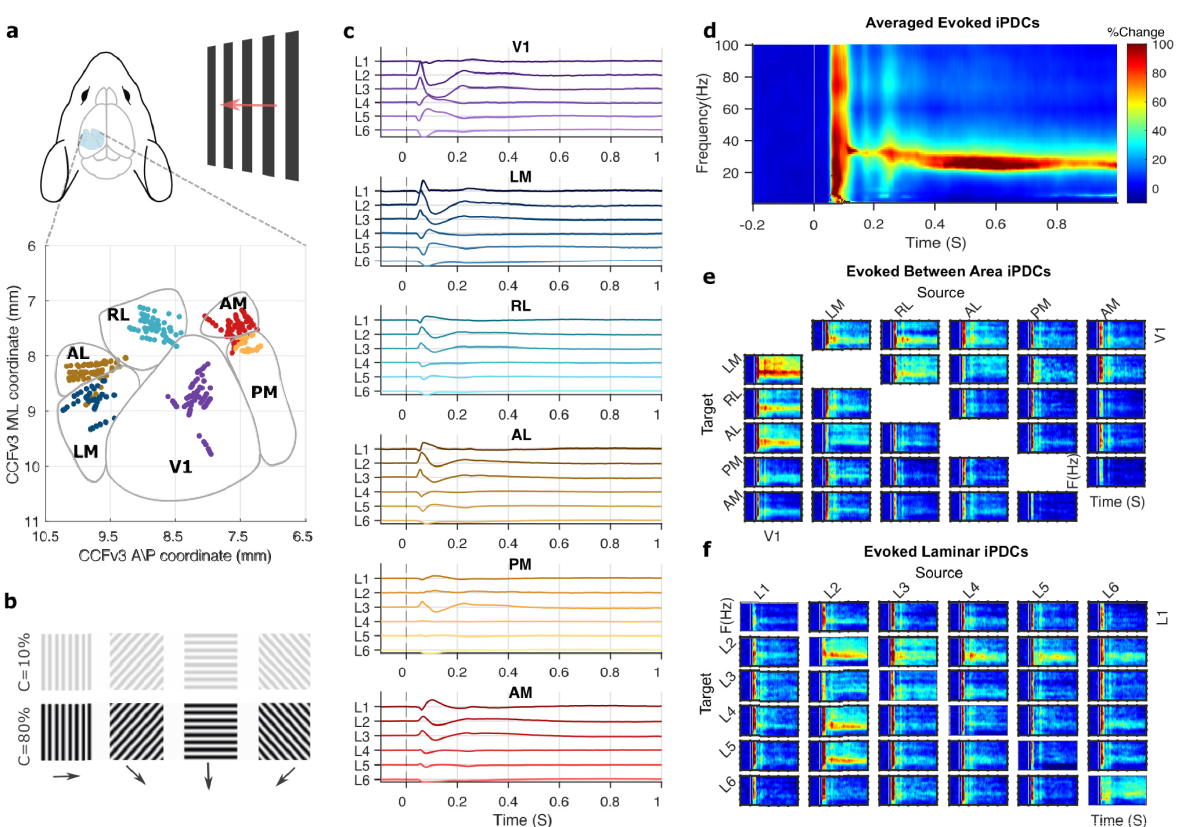
Fig 1. Visual stimuli evoke large-scale activity and functional interactions. (a) Laminar recording sites across cortical areas from 11 mice, in the Allen Institute for Brain Science’s standard CCFv3 space. (b) Visual stimuli were drifting gratings (2 Hz) of high (80%) or low (10%) contrast, presented for 2 S. (c) Grand average bipolar LFPs for high contrast stimuli, for L1 to L6 in 6 visual areas, shown in anatomical hierarchical order [7]. (d) Directed functional connectivity (iPDC) in the time and frequency domain, averaged over all areas, layers, and animals. (e) Time–frequency connectivity between areas, averaged over layers, and animals. (f) Time–frequency connectivity between layers, averaged over areas, and animals. Heatmaps show percentage of poststimulus change following the colormap in d , columns indicate sources, and rows indicate targets of directed functional interactions. Underlying data: https://osf.io/pqf7z. i AU : AbbreviationlistshavebeencompiledforthoseusedthroughoutFigs 1 (cid:0) 6 : Pleaseverifythatallentriesarecorrect : PDC, information partial directed coherence; LFP, local field